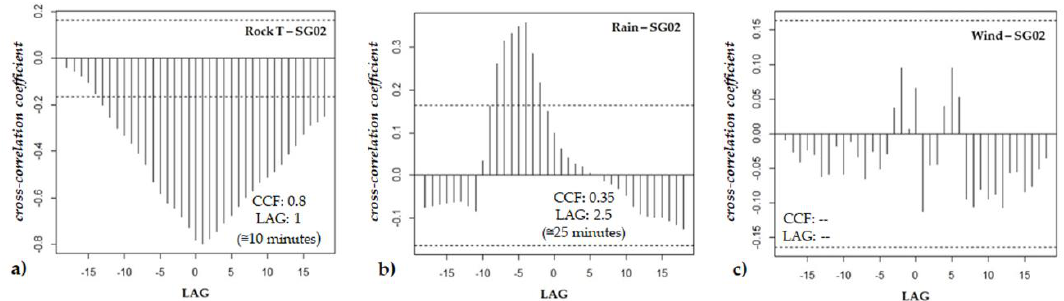
Figure 10. Correlograms indicating examples of cross-correlations between: ( a ) the rate series of the rock temperature and the strain; ( b ) the rate series of the rainfall and the strain; ( c ) the rate series of storm wind and the strain. The LAG value is expressed as a multiple of the sampling step of R 2 (equal to 10 min in our case).